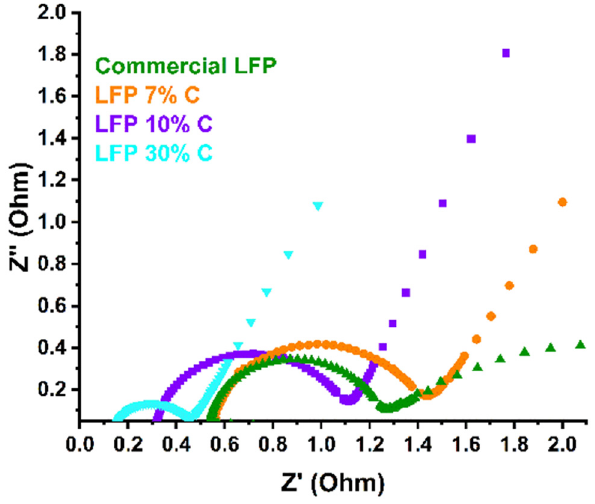
Figure 10: Nyquist plot of LiFePO 4 /C samples in cylindrical